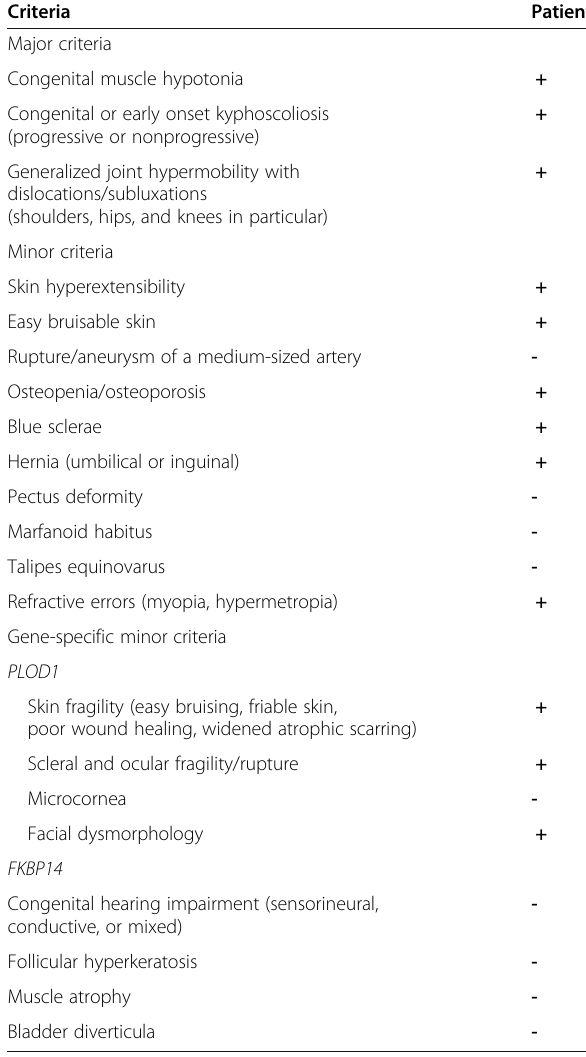
Table 1 Criteria of kEDS from 2017 International EDS Classification and clinical manifestations of the